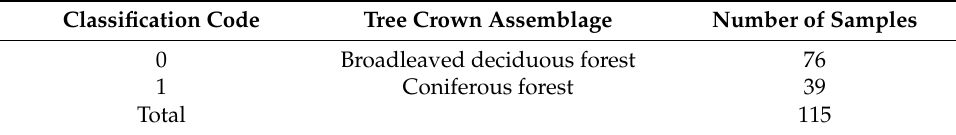
Table 2. Definition of forest classes training